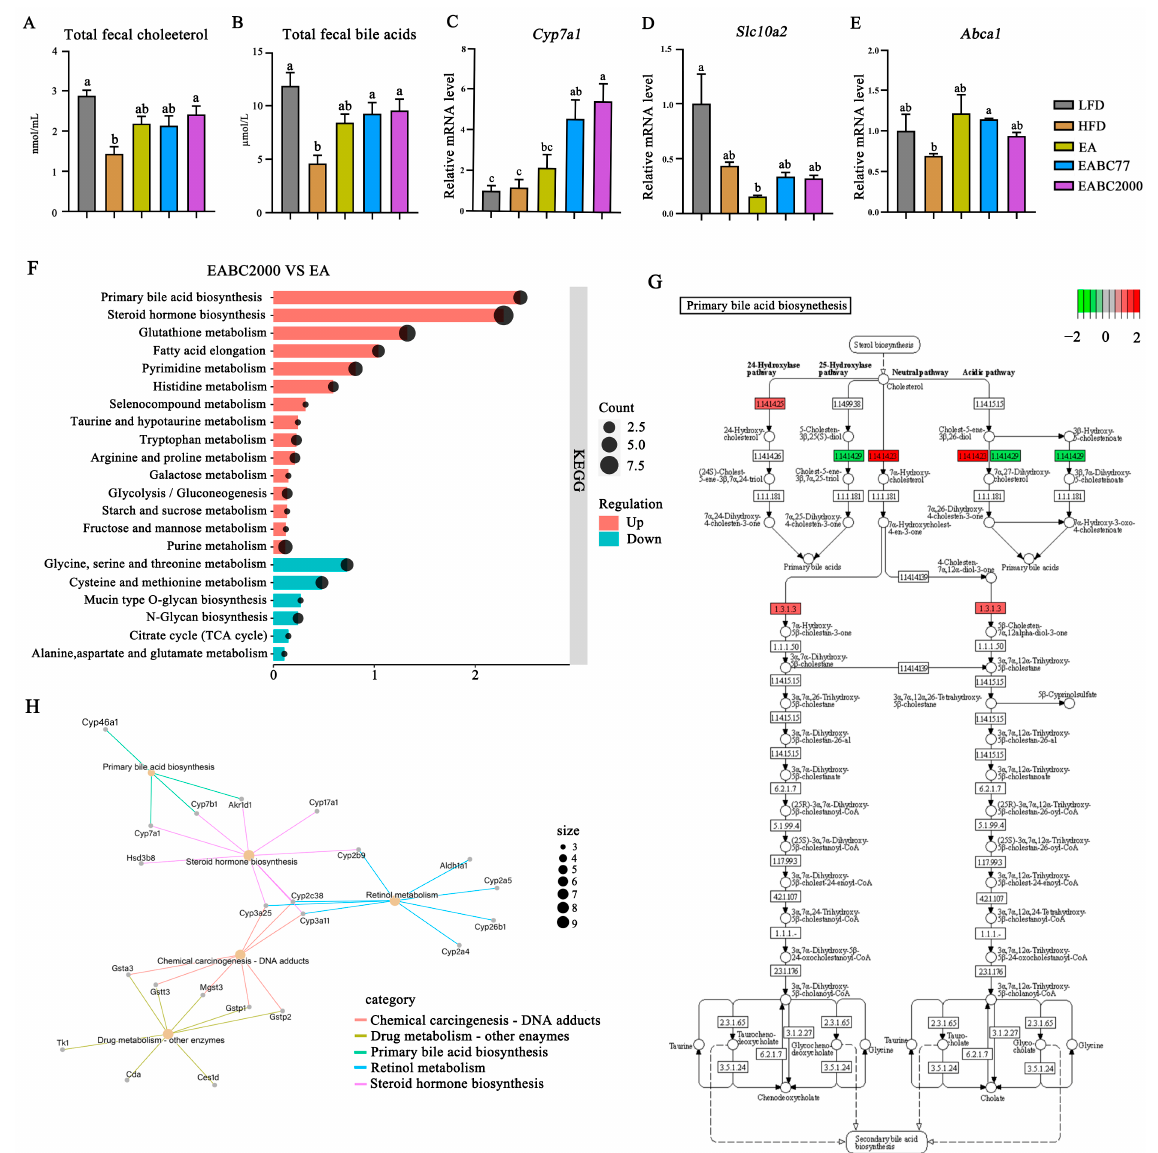
Figure 5. Effect of jointly consuming Weizmannia coagulans BC2000 and ellagic acid on cholesterol metabolism. ( A ) Total fecal cholesterol; ( B ) total fecal bile acids; ( C ) relative expression of gene Cyp7a1 ; ( D ) relative expression of gene S1c10a2 ; ( E ) relative expression of gene Abca1 ; ( F ) differential gene KEGG enrichment analysis; ( H ) protein–protein interaction networks map based on differentially expressed genes; ( G ) KEGG pathway map of primary bile acid biosynthesis. Different lowercase letters above the bars represent significant inter-group differences by Tukey’s test ( p < 0.05). n = 4 in each group (total fecal cholesterol and total fecal bile acids, n = 5 in each group). LFD: low-fat-diet group; HFD: high-fat-diet group; EA: EA intervention group; EABC77: EA + Weizmannia coagulans BC77 intervention group; EABC2000: EA + Weizmannia coagulans BC2000 intervention group.